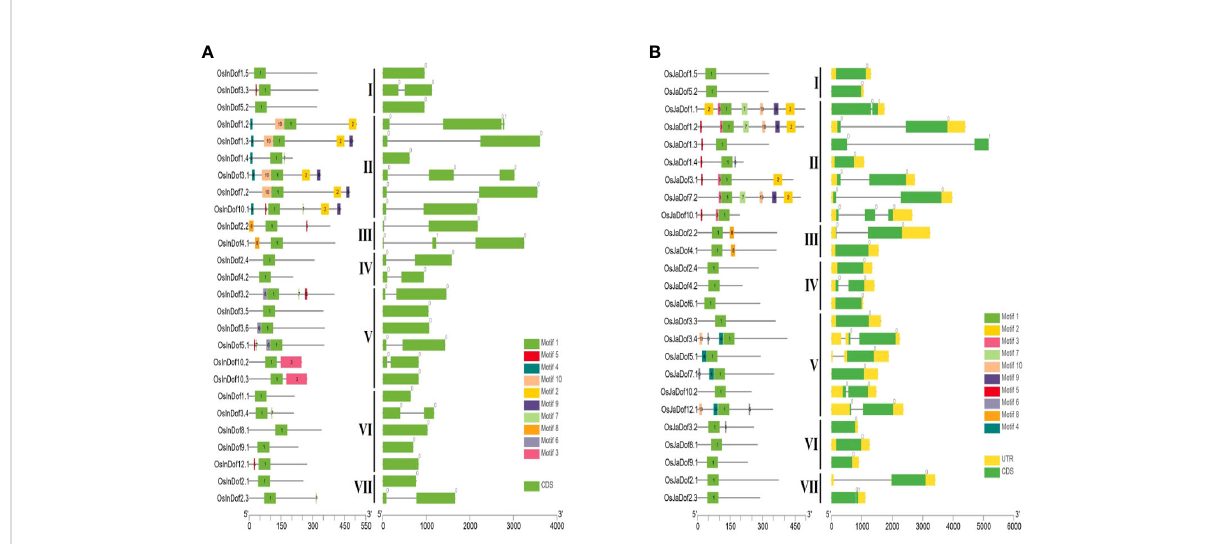
FIGURE 3 Conserved motifs and gene structures of Dof genes in (A) indica and (B) japonica rice. Conserved motifs were identi fi ed by uploading amino acid sequences to the MEME online tool (Bailey et al., 2009) and displayed on protein lengths with TBtools (Chen et al., 2020). Similarly, gene structures were drawn on genomic lengths by using respective GFF3 fi les of both rice types. Sub-groups are indicated with Roman numbers (I − VII) in the middle of both fi